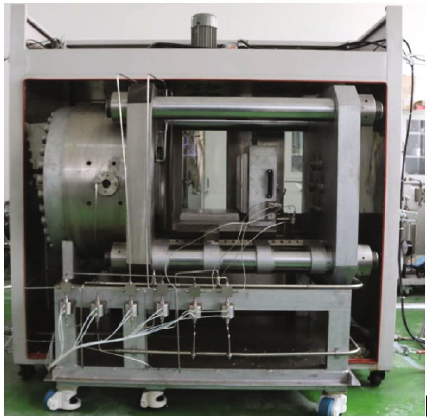
Figure 2: 300R2 high temperature and high stress hydraulic fracturing simulation equipment. Table 2: Physical simulation experiment parameters. Sample